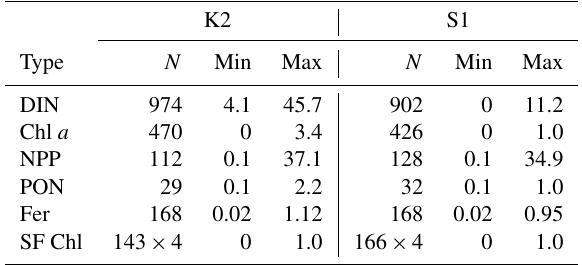
Table 3. Observational data at stations S1 and K2. N : number of observations. Min and Max are minimal and maximal values used in data normalization (see Sect. 2.4 for details). DIN: dis- solved inorganic nitrogen (µmolL − 1 ) . Chl a : total chlorophyll a concentration (µgL − 1 ) . NPP: net primary production measured by 13 C uptake (µgCL − 1 d − 1 ) . PON: particulate organic